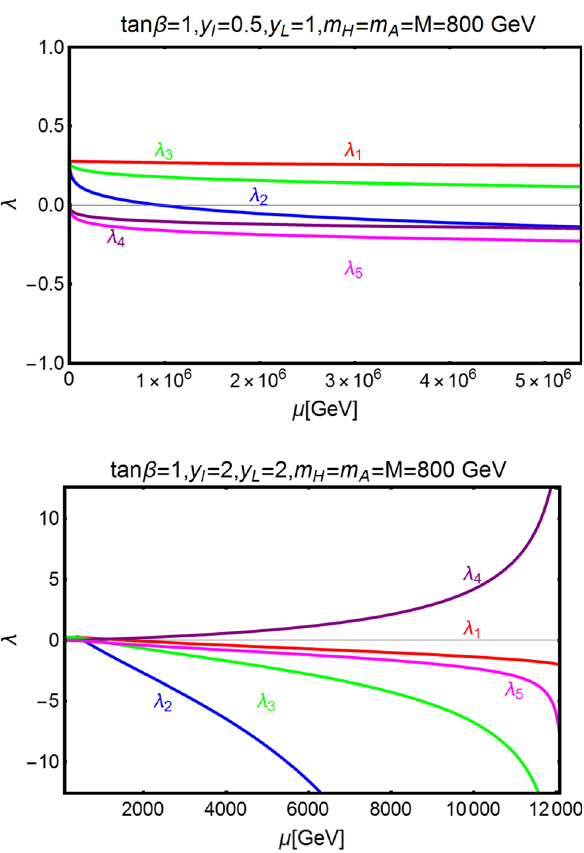
Fig. 7 Two examples of resolution of the RGE equations. The corre- sponding assignations of the relevant model parameters are reported on top of the panels . In the upper panel the initial values of the Yukawa couplings are sufficiently small such that the conditions (34) and (35) are satisfied up to energy scales of the order of 10 6 GeV. In the lower panel the assignation of the Yukawas causes, instead, the couplings λ 1 , 2 to become negative already at the energy threshold of the